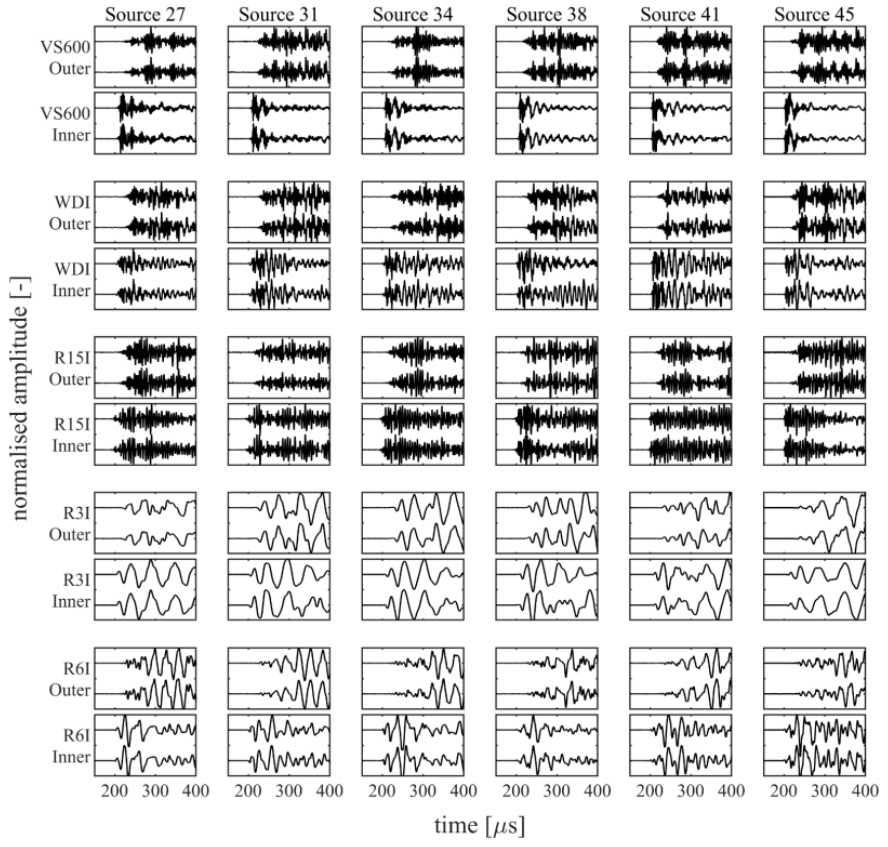
Figure 5. Overview of the recorded waveforms for several inner raceway sources. Each block depicts a 250 µ s sample of two waveforms that have been normalised with their respective peak amplitudes.